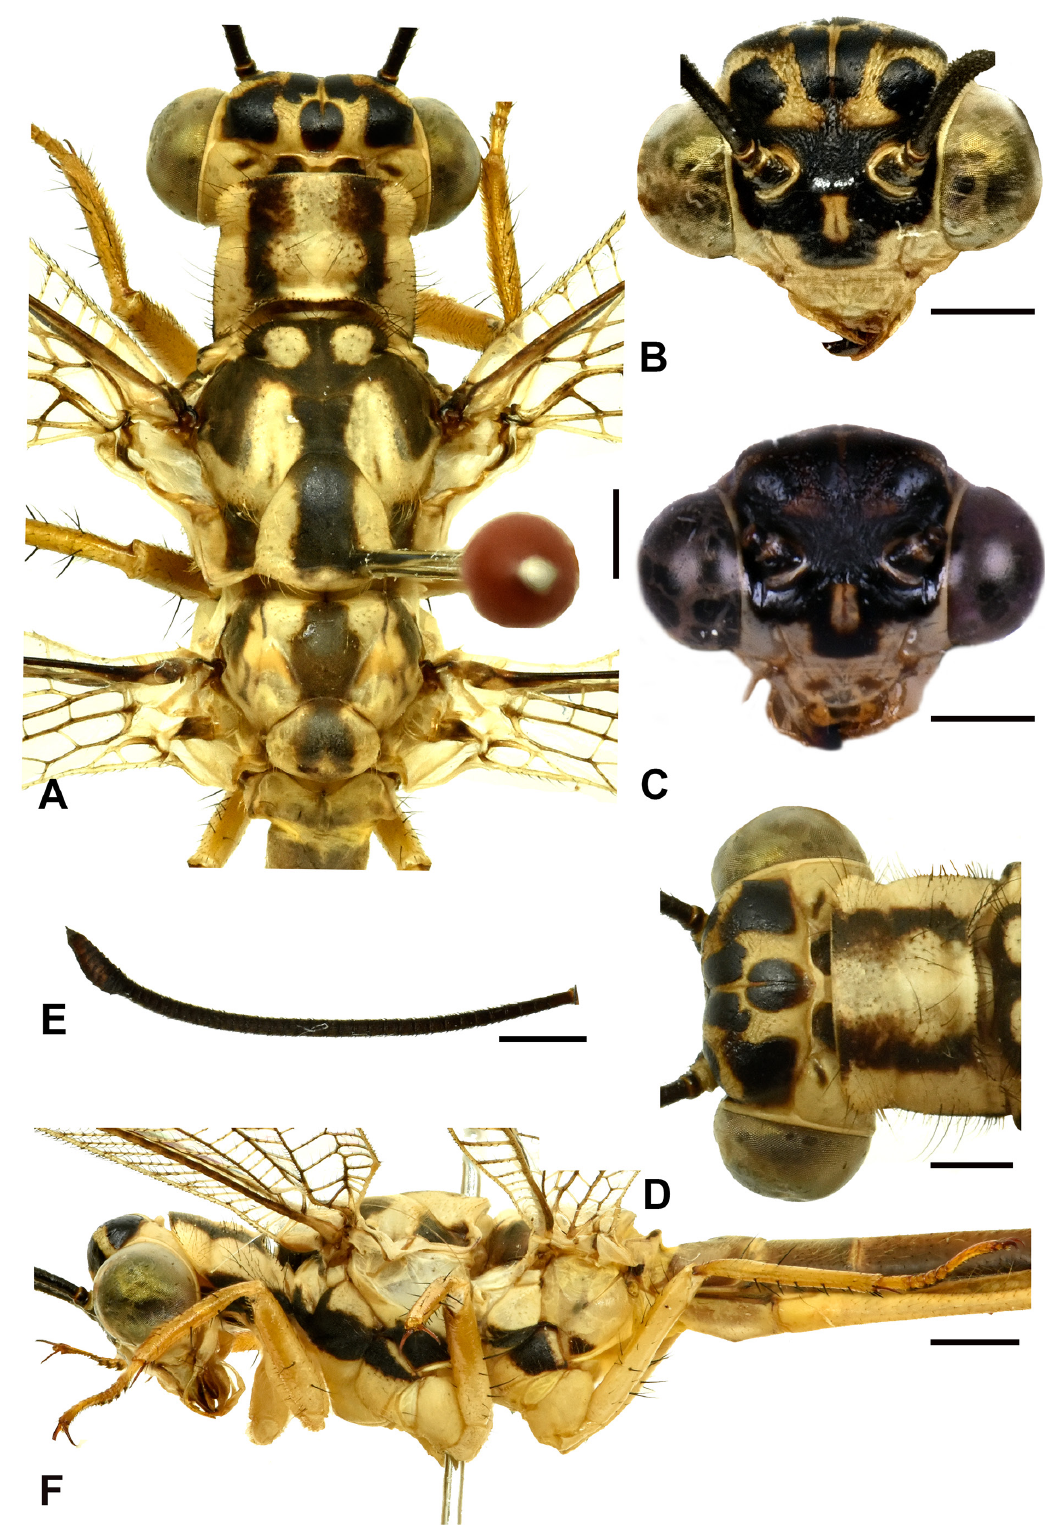
Fig. 3. Baliga kashmirensis sp. nov. A . Dorsal habitus of head and thorax. B – C . Head, frontal view. D . Head and pronotum, dorsal view. E . Antenna. F . Lateral view. A–B, D–F: ♂ (CAUPK00001); C: ♂ (CAUPK00003). Scale bars: A = 2.0 mm; B–E = 1.0 mm; F = 3.0